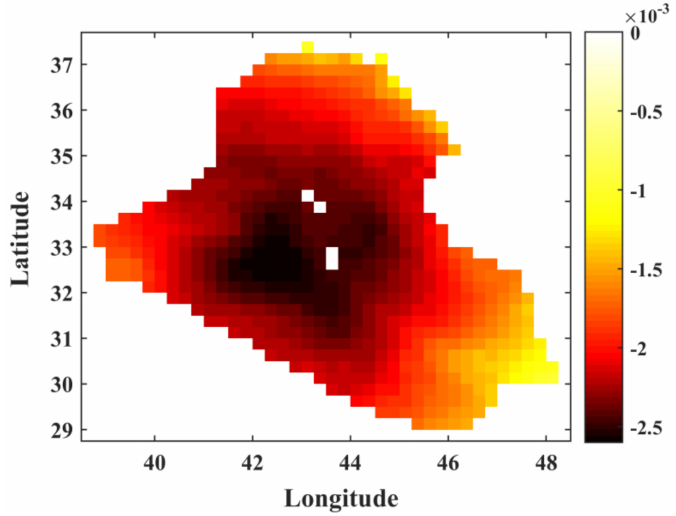
Figure 5. Long-term trends of drought intensity for the period of 1948–2009 according to the SPEI-12.